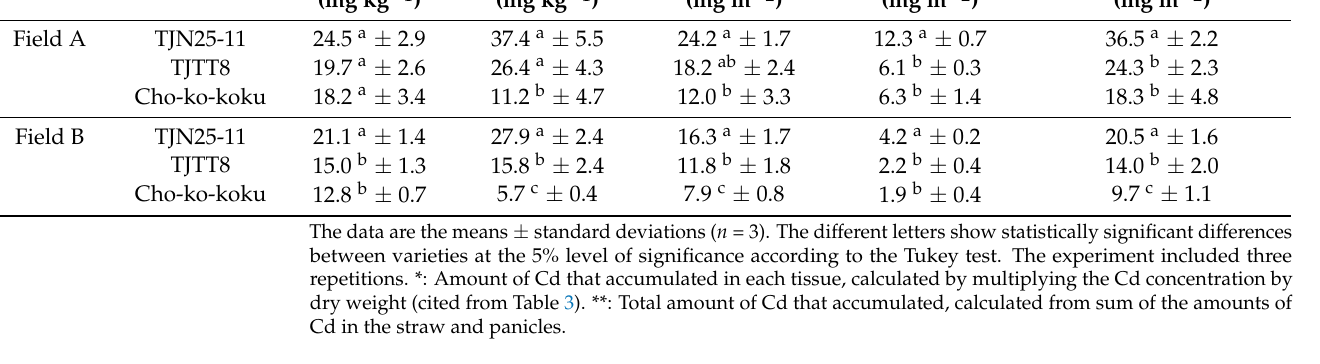
Table 5. Changes in soil Cd concentrations before and after planting and phytoextraction efficiency.